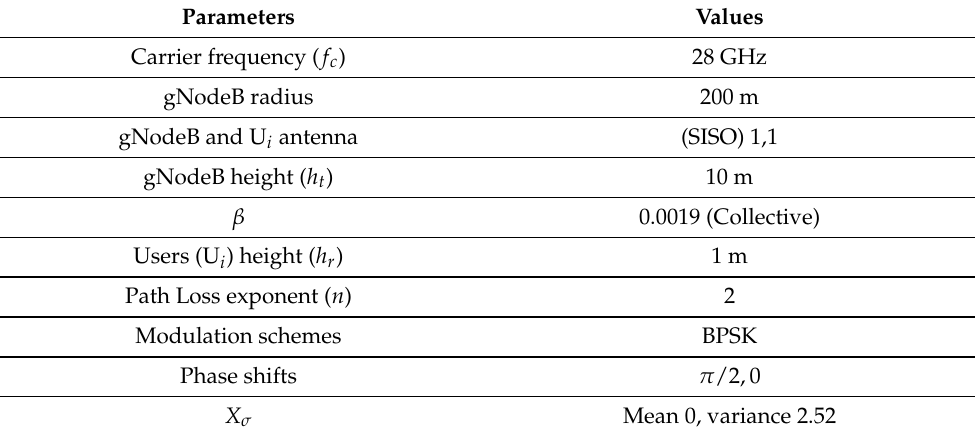
Table 2. Parameters used in implementation of System